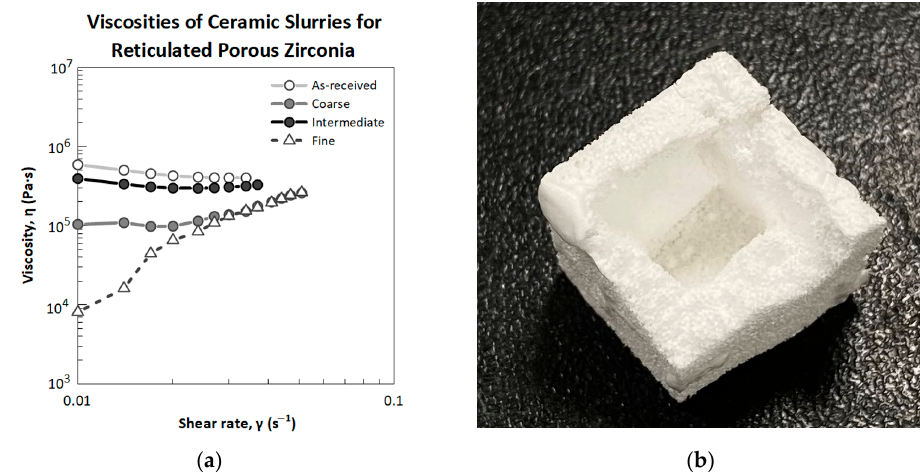
Figure 8. ( a ) Viscosities of the zirconia slurries for the preparation of reticulated porous zirconia: as-received, coarse, intermediate, and fine zirconia particles; ( b ) fractured reticulated porous zirconia specimen with a pore density of 80 PPI, which possesses internal macro-voids.